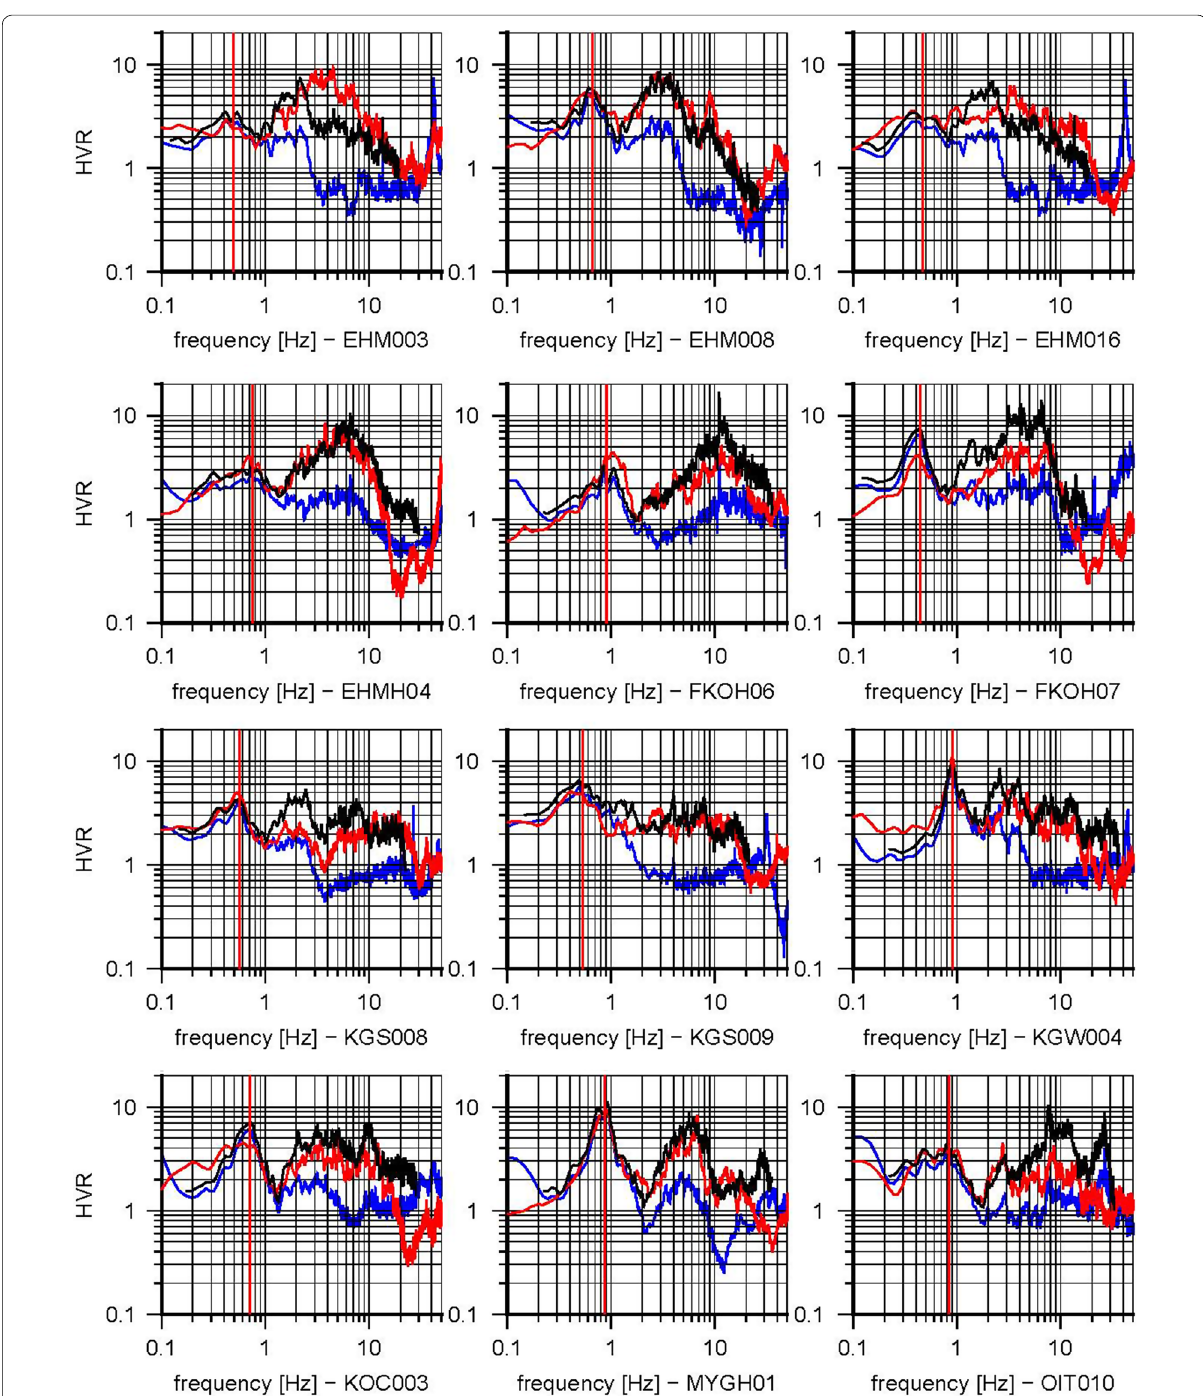
Fig. 13 Direct comparison of the EHVRs of S-wave (red), the MHVRs for microtremors (blue), and the pEHVRs translated from MHVR by using the empirical EMR of Category 1 (black). We can see significant shift of amplitude toward EHVR. Red vertical lines are the fundamental peak frequencies